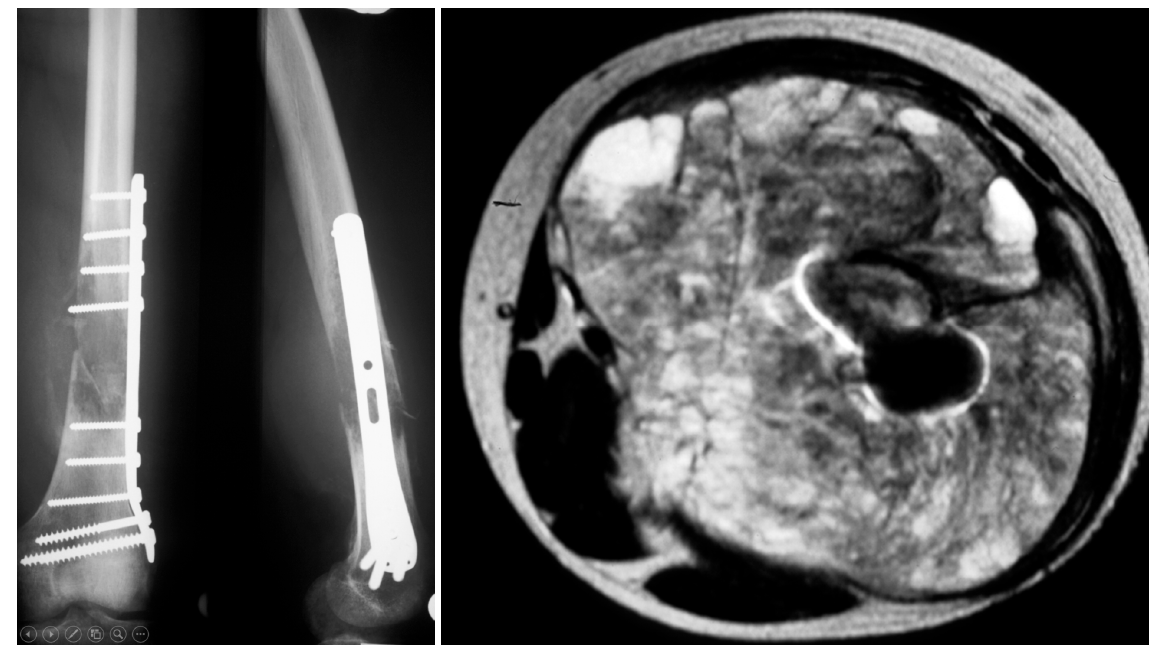
Figure 2. Radiographs and axial MRI of a patient with an osteosarcoma. After pathological fracture an osteosynthesis has induced widespread contamination and tumor growth of the whole distal upper calf.